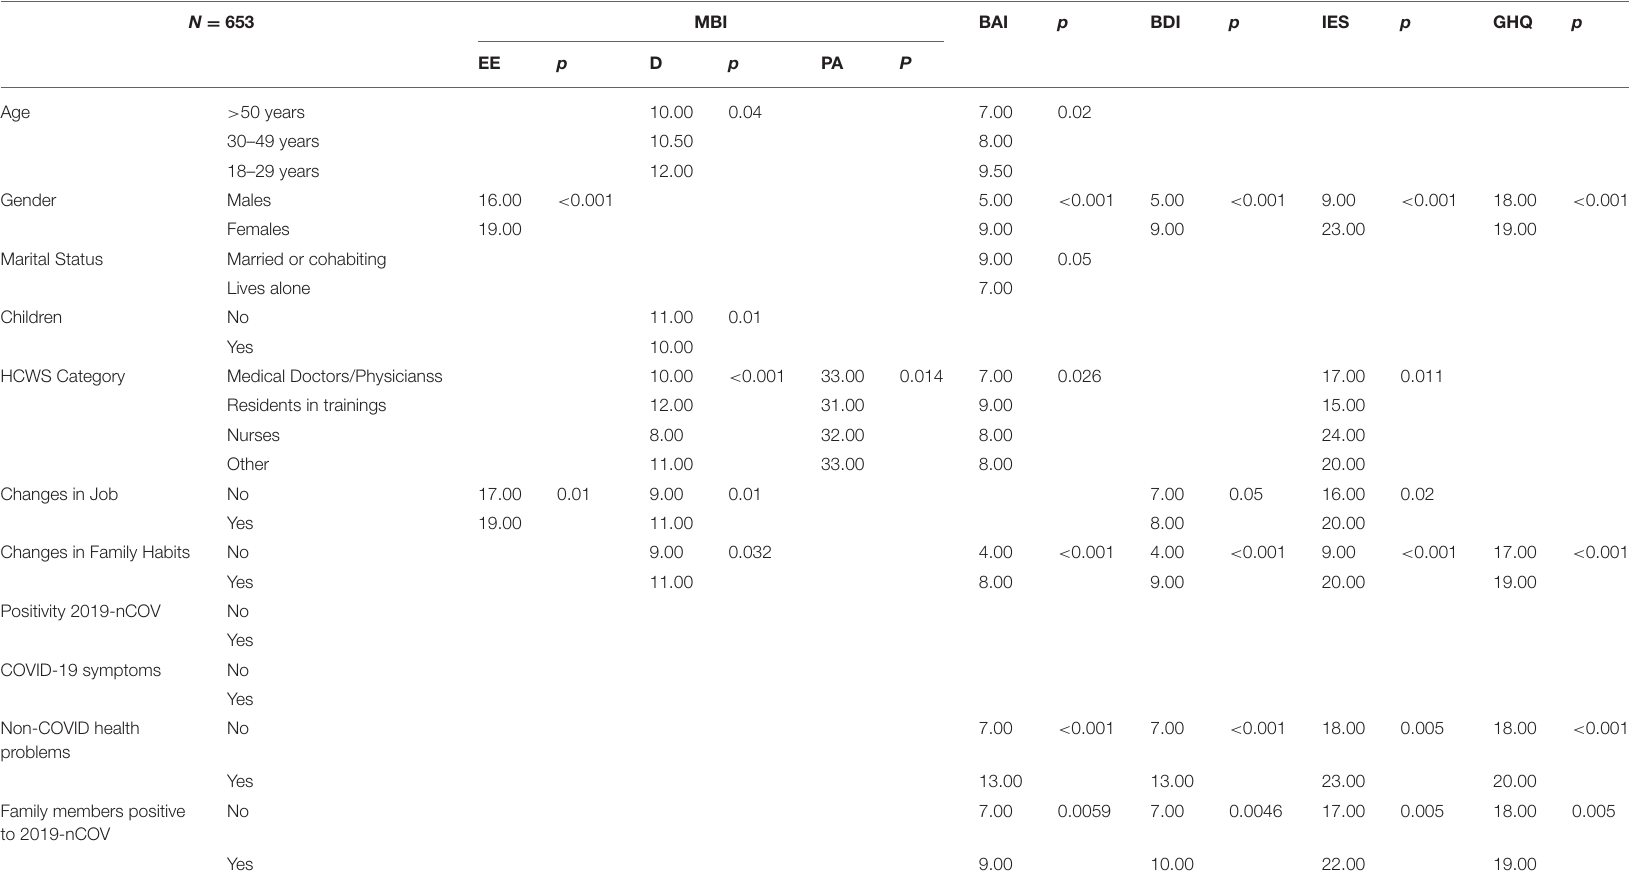
TABLE 3 | Wilcoxon type comparison of median test scores in the sample (N = 653), according to the socio-demographic and COVID-19-related information. N =